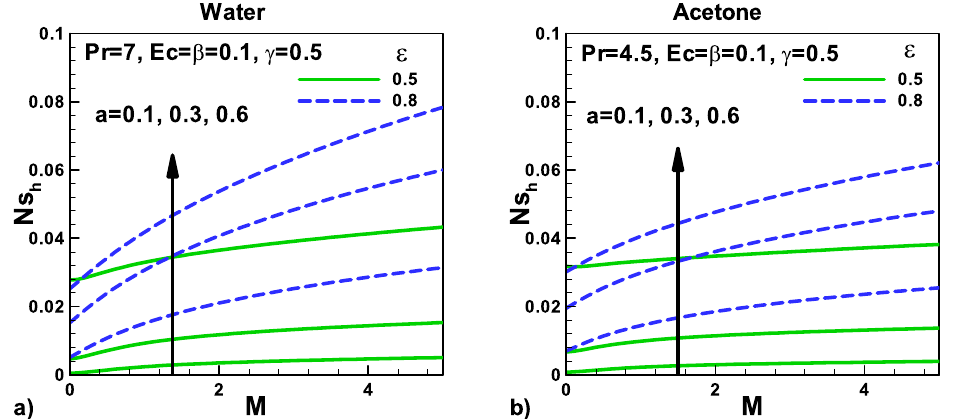
Figure 10. Variation of entropy generation rate due to heat with magnetic field and velocity ratio parameter at different positions for ( a ) water ( b ) acetone.